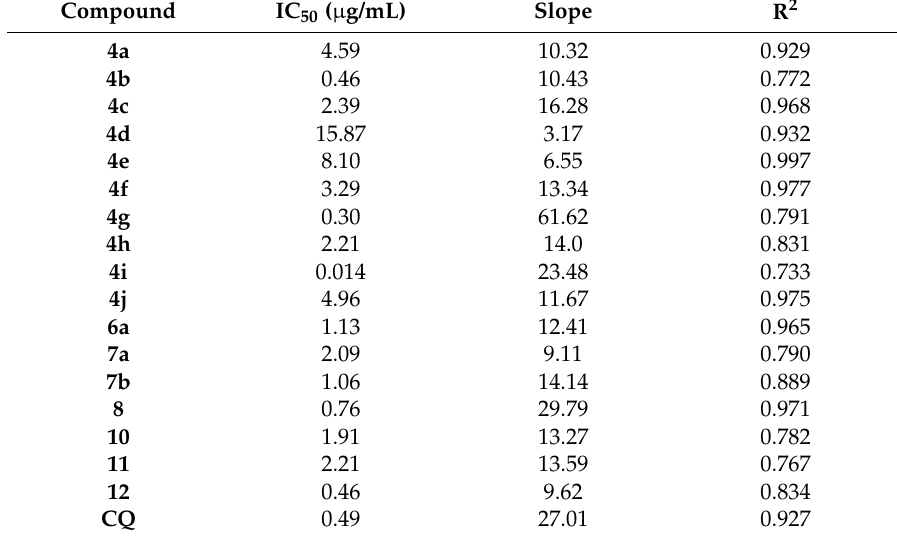
Table 3. IC 50 values of some derivatives compound of chloroquine against Plasmodium falciparum .